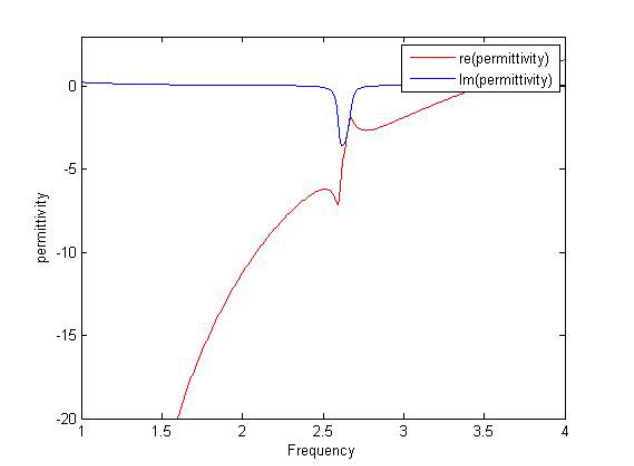
Figure 4: Permittivity of unit cell